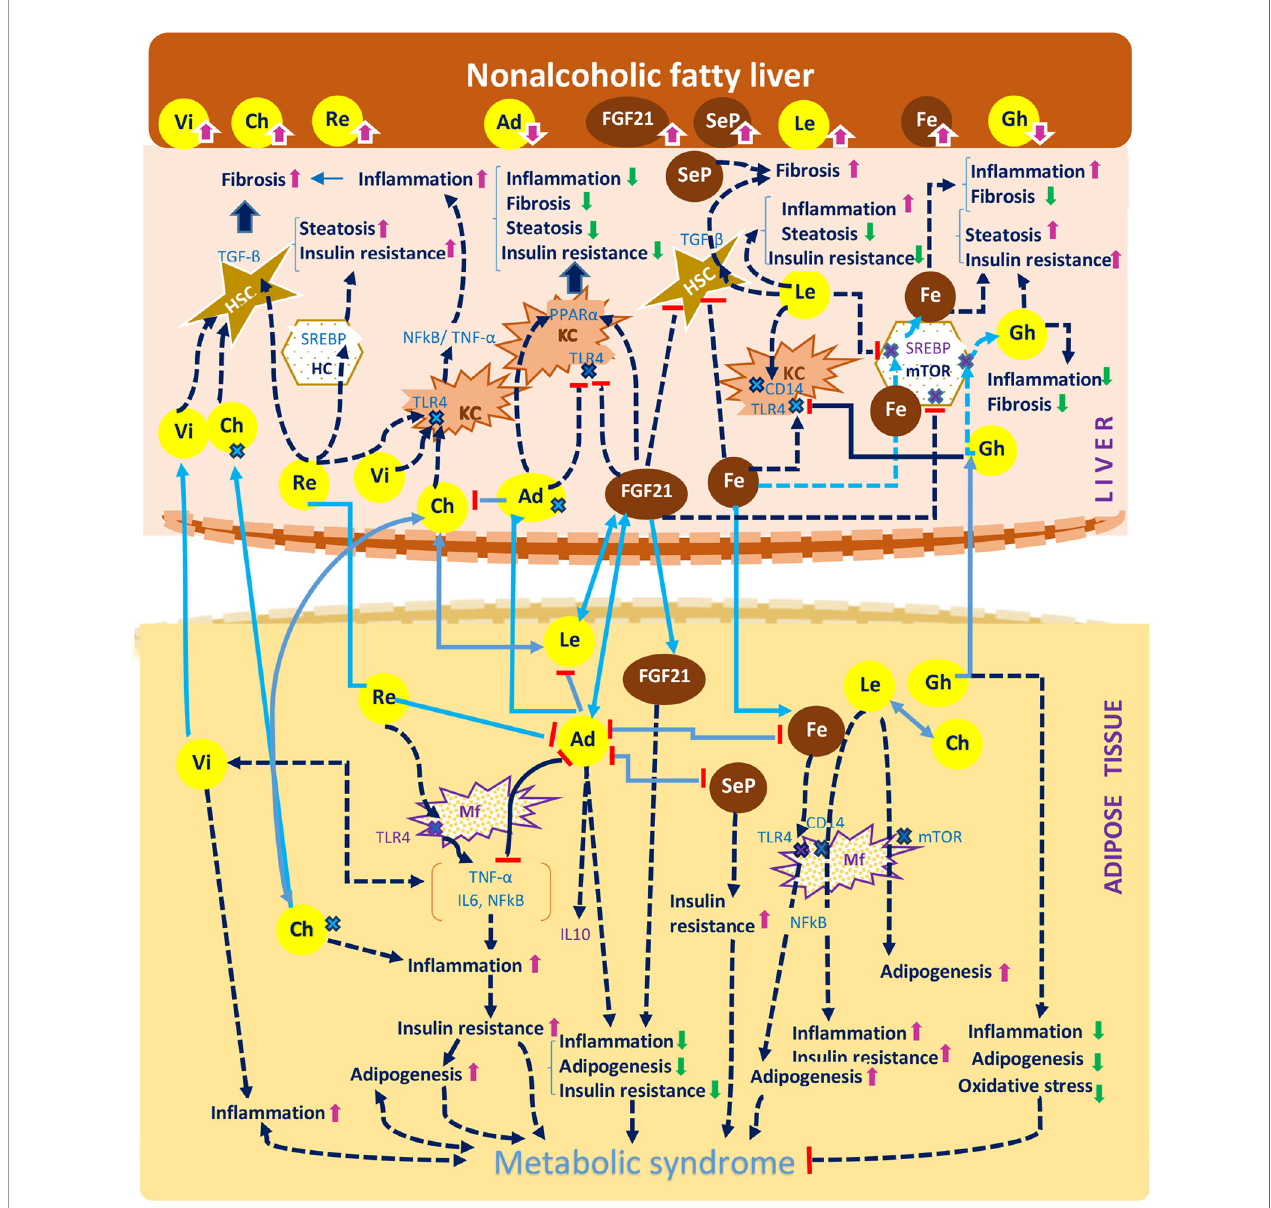
FIGURE 1 | A concise representation of the hepatokines and adipokines presented in the article and their implications in the pathogenesis of non-alcoholic fatty liver disease according to the current studies.The diagram indicates the effect of hepatokines (FGF21, selenoprotein P, fetuin A, chemerin) and of the adipokines (visfatin, resistin, adiponectin, ghrelin), against the mechanisms that drive the pathogenesis of NAFLD, namely steatosis, in fl ammation, fi brosis and insulin resistance and also against the development of the metabolic syndrome, namely adipogenesis, in fl ammation and insulin resistance. The diagram depicts the following processes: a. The effects of organokines on liver in fl ammation: visfatin, chemerin, leptin, resistin, fetuin A activate the NF-kB and TNF- a /IL6 pathway and induce a proin fl ammatory effect mediated by Kuppfer cells (KCs). The previous organokines exhibit high concentrations in NAFLD. By comparison, adiponectin, FGF21 and ghrelin exert an anti-in fl ammatory effect. b. The effects of organokines on liver fi brosis: visfatin, chemerin, leptin, selenoprotein P mediate the release of TGF- b in hepatic stelatte cells (HSCs), while adiponectin and FGF21 exert an anti fi brotic effect. c. The additive effect of organokines against the evolution of the metabolic syndrome: visfatin, chemerin and leptin promote the metabolic syndrome through their proin fl ammatory and proadipogenic effect, as well as through their role in the aggravation of insulin resistance. On the other hand, adiponectin and FGF21 play a protective role against the metabolic syndrome. Organokines can stimulate each other (e.g: adiponectin and leptin with FGF21) or inhibit each other (e.g: fetuin A, leptin, selenoprotein P, resistin with adiponectin). Organokines synthesized predominantly in the liver are presented in brown and those synthesized predominantly in the adipose tissue are presented in yellow. The correlations between these different organokines are shown in blue. The serum concentrations of these organokines in NAFLD (high or low) are represented by arrows. Vi, visfatin; Re, resistin; Fe, fetuin A; Le, leptin; Ch, chemerin; Ad, adiponectin; Gh, ghrelin; SeP, selenoprotein; Re, resistin; Mf, macrophage; HC, hepatic cell;